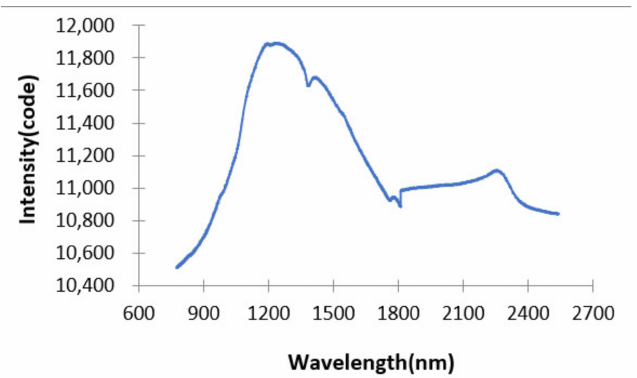
Figure 24. The combined short wavelength and long wavelength spectra. Narrow-band filters were selected for the resolution test and the half-width of the filters was calculated. Figure 25 is the resolution test result of detector 1. Two narrow-band filters with a central wavelength of 1570 nm and 1580 nm were selected, respectively. It can be seen from the figure that the two characteristic peaks of 1570 nm and 1580 nm can be essentially separated. In general, the resolution of the central region of the spectrum detection range was better than that of the two ends of the spectrum detection range. Therefore, the spectrum resolution of detector 1 (800–1646 nm) was generally better than that of 12 nm.